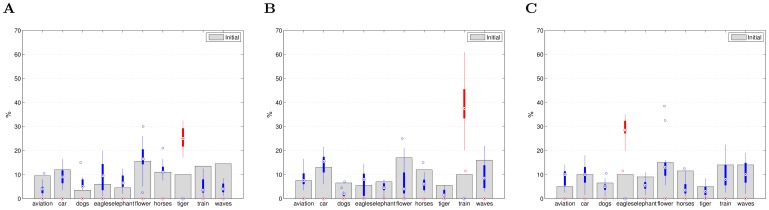
Distributions of the images in the initial RSVP sequences (gray bars) and the retrieved set of images, after the last iteration, over the classes.Distributions of the retrieved images are given across the subjects as a boxplot: the median (the central mark of the box), the 25th and 75th percentiles (the edges of the box) and the most extreme values (thin lines). Red color indicates the target class. (A) Search task: “Tiger”. (B) Search task: “Train”. (C) Search task: “Eagles”.